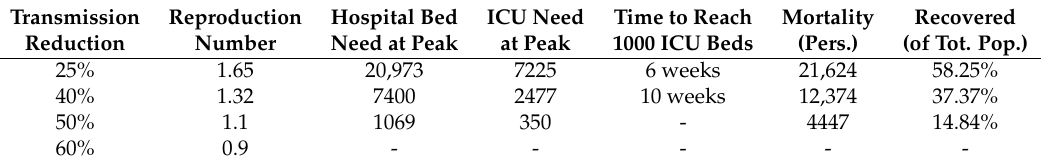
Figure 8. Hospitalization, ICU demand, and incidence curves. The figures show the required number of hospital beds (classes I h + I cr , yellow) and ICU beds (class I c , red) need in the first row for R ∈ { 1.65,1.32,1.1 } , respectively. The second row illustrates the daily incidence (transition from compartment S to L 1 in our model, orange) combining all age groups. Note that the incidence curves peak earlier than the hospitalization curves. The legend at the bottom applies for all figures. Note that the scalings of the figures are different. Table 8. Indicative values of the epidemics in case of the applied control measures. Hospital and ICU bed need at the peak, mortality and the number of recovered people with the expected time it takes to reach 1,000 ICU beds is shown in case our control scenarios. See the corresponding time series in Figure